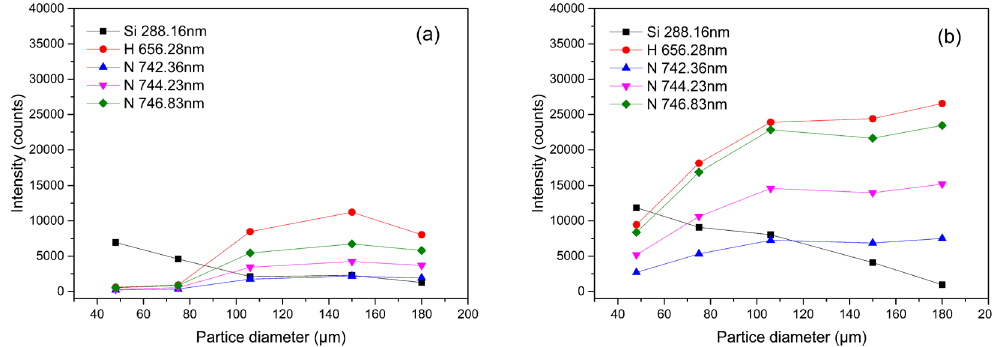
Figure 4. Variation of line intensity with particle diameter: ( a ) Cu electrode; ( b ) W electrode.